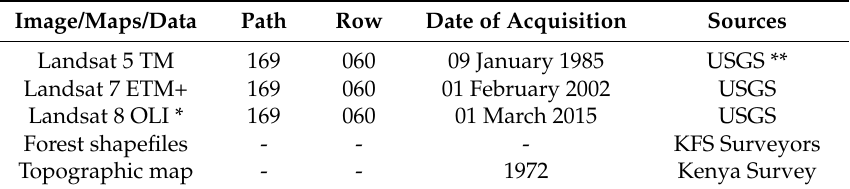
Table 1. Landsat images, maps, and secondary data used in the study. KFS: Kenya forest service. Image/Maps/Data Path Row Date of Acquisition Sources Landsat 5 TM